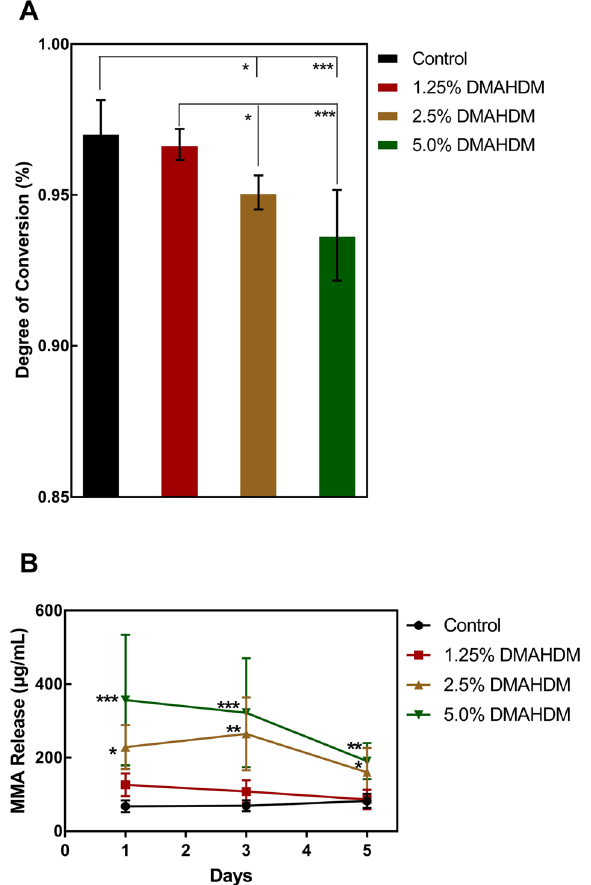
Fig. 4 Degree of conversion (DC) and unpolymerized monomers releasing. A DC, and ( B ) MMA release. (mean ± SD; n = 6. * p < 0.05. ** p < 0.01. *** p <